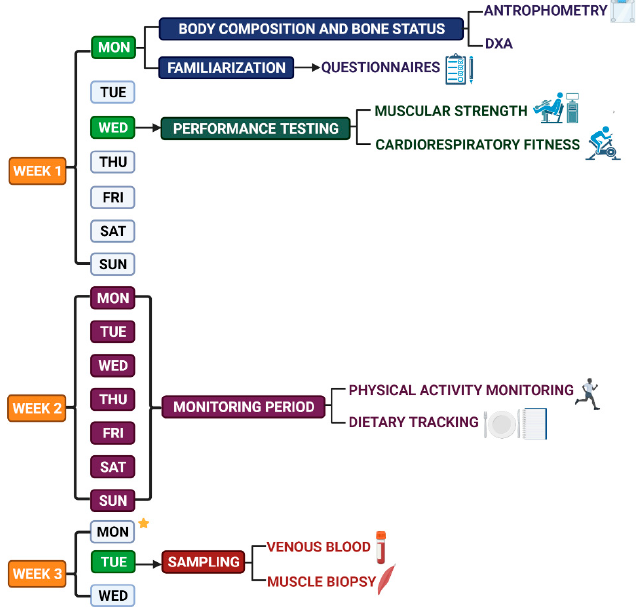
Figure 1. Data Collection Scheme per subject. Created with BioRender.com.